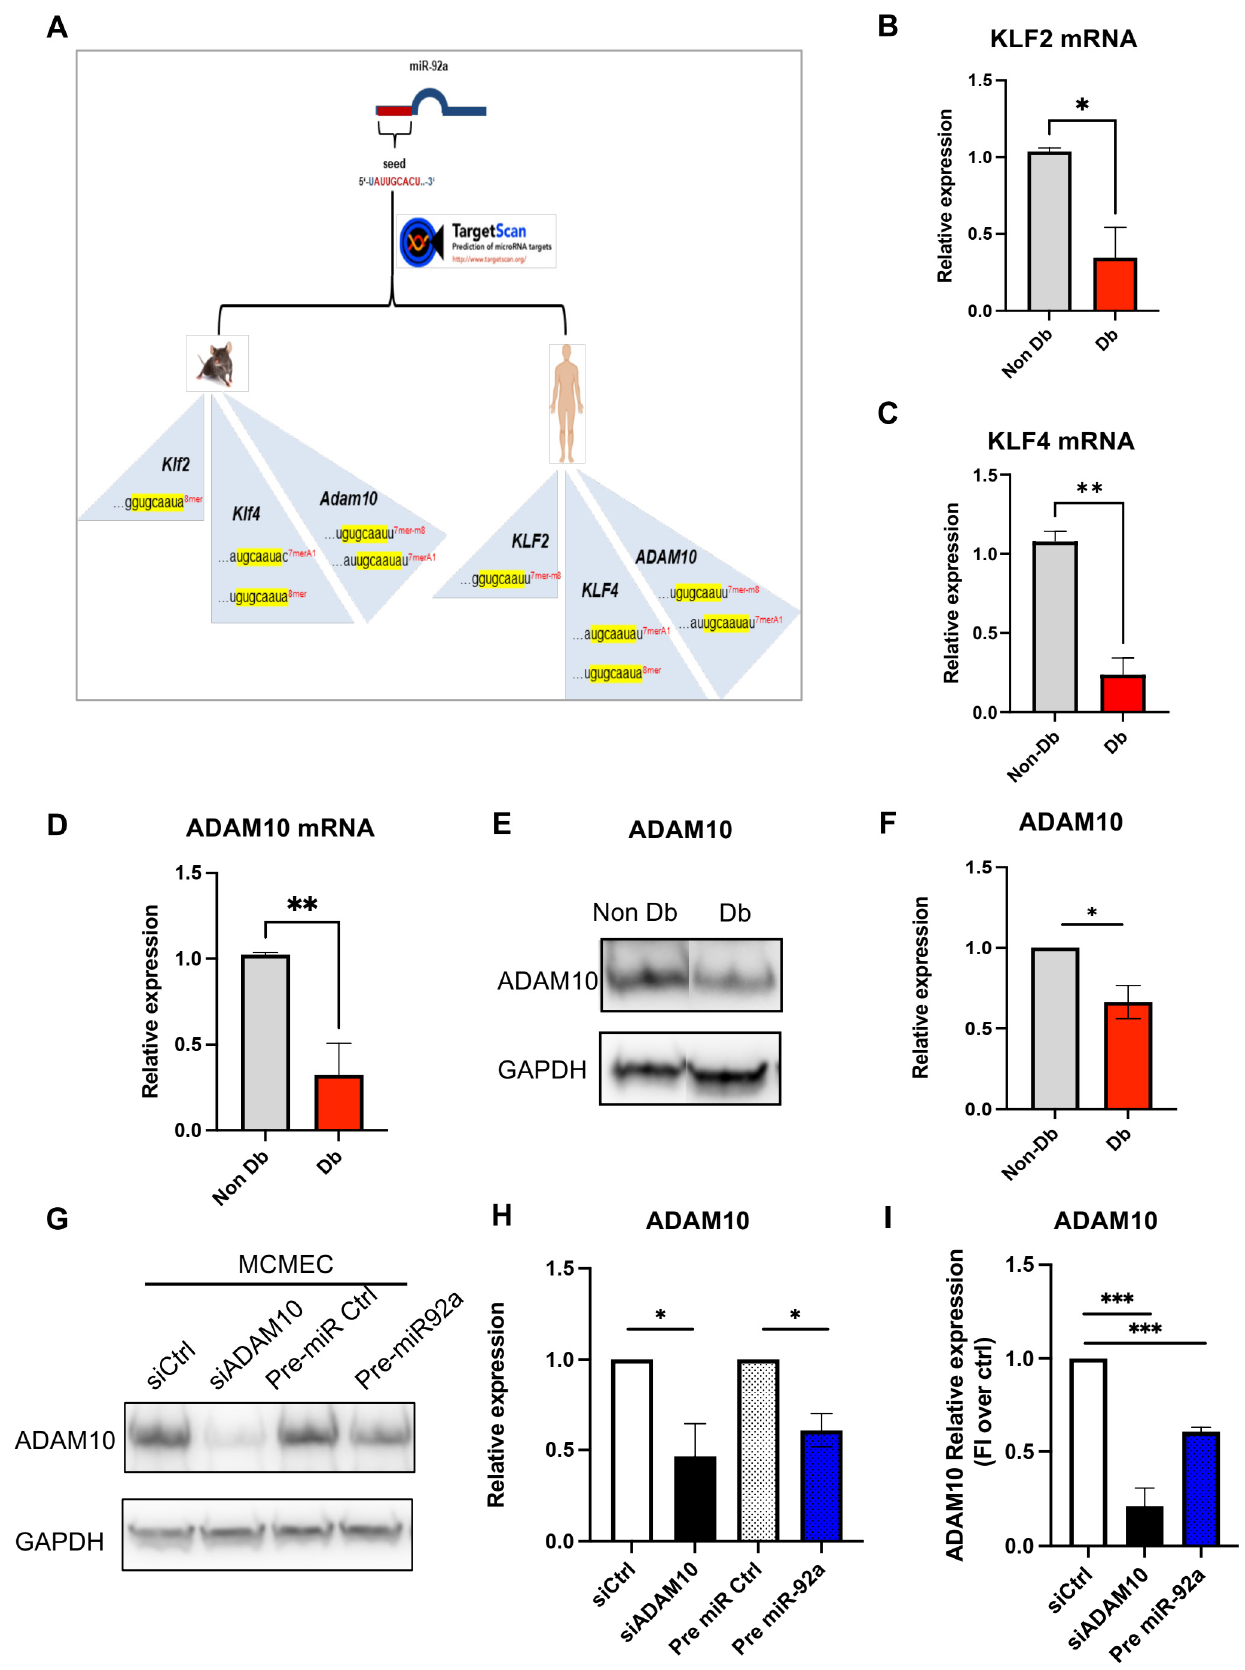
Figure 4. miR-92a downstream targets. ( A ) TargetScan in silico prediction of conserved